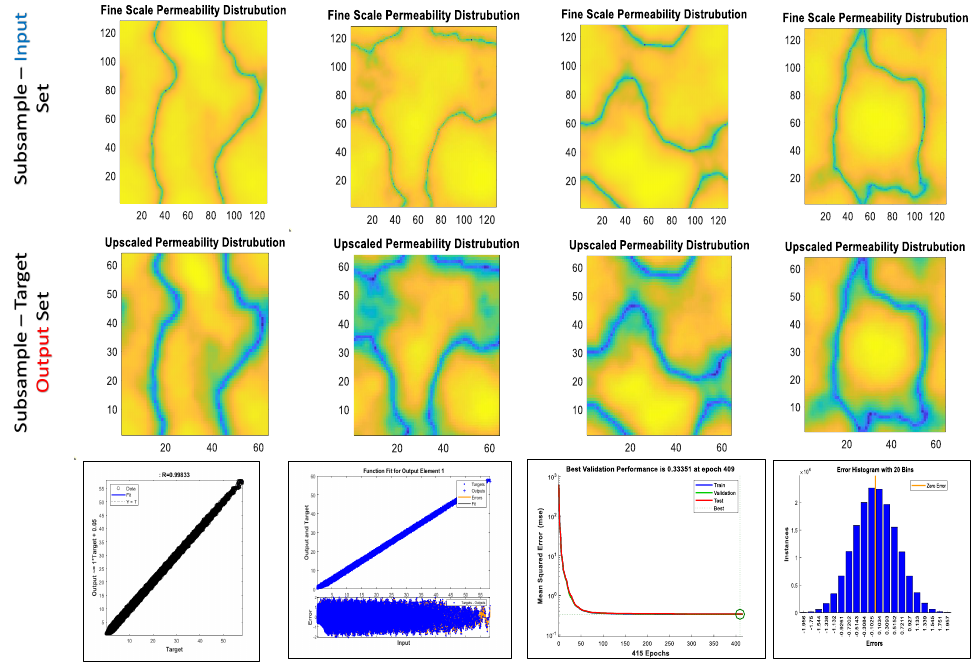
Figure 14. Figure showing a sample subset of input and output target permeability distribution used for the network training along with outcome of the network